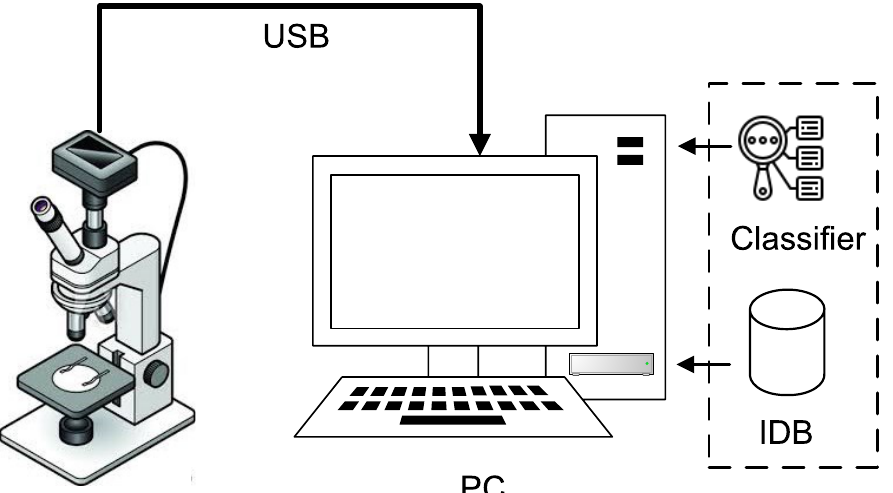
Figure 3. Block diagram of the biofuel material identification system: PC—Personal Computer; IDB—database of biofuel images for training the classifier; USB—serial connection between the digital camera of the microscope and the